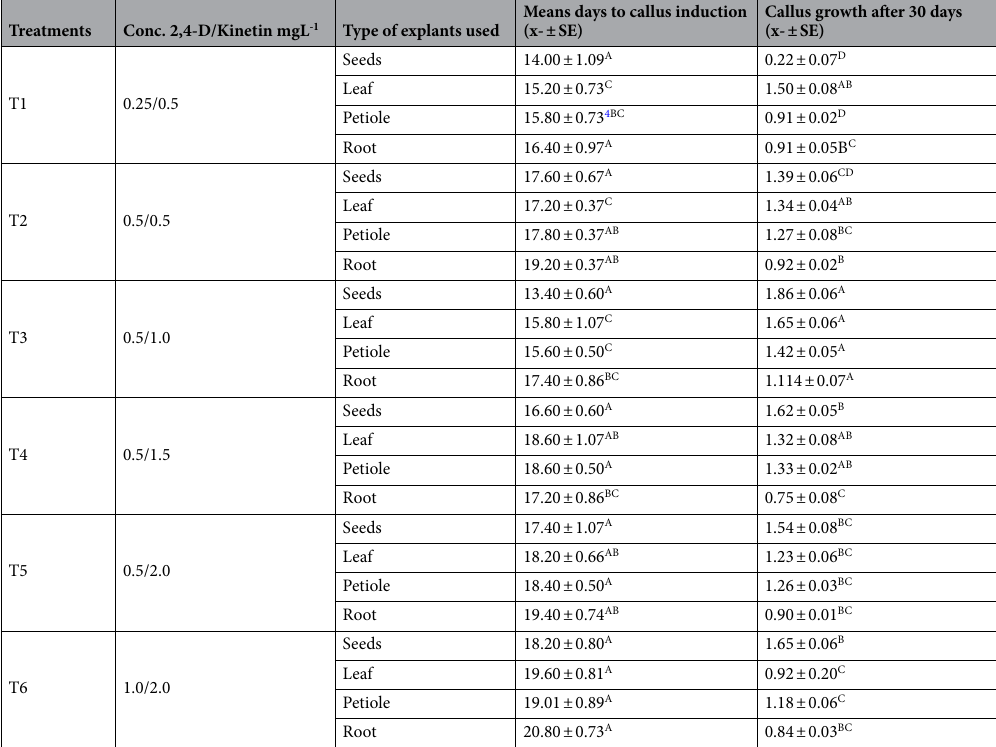
Table 2. In-vitro callus induction and callus growth after 30 days of culturing of S. costus using seed, leaf, petiole and root as an